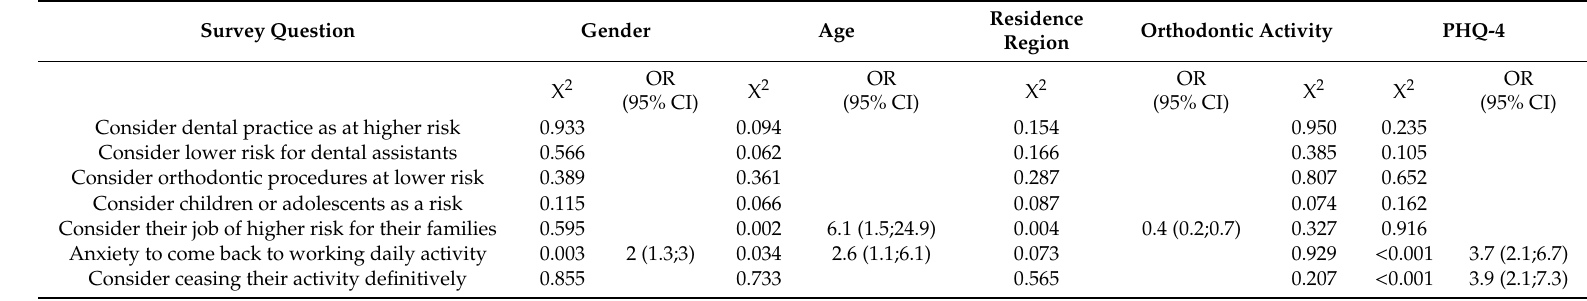
Table 3. Chi-square test and regression analysis for perceived risk, anxiety, and distress questions and gender, age, residence region, orthodontic activity, PHQ-4.